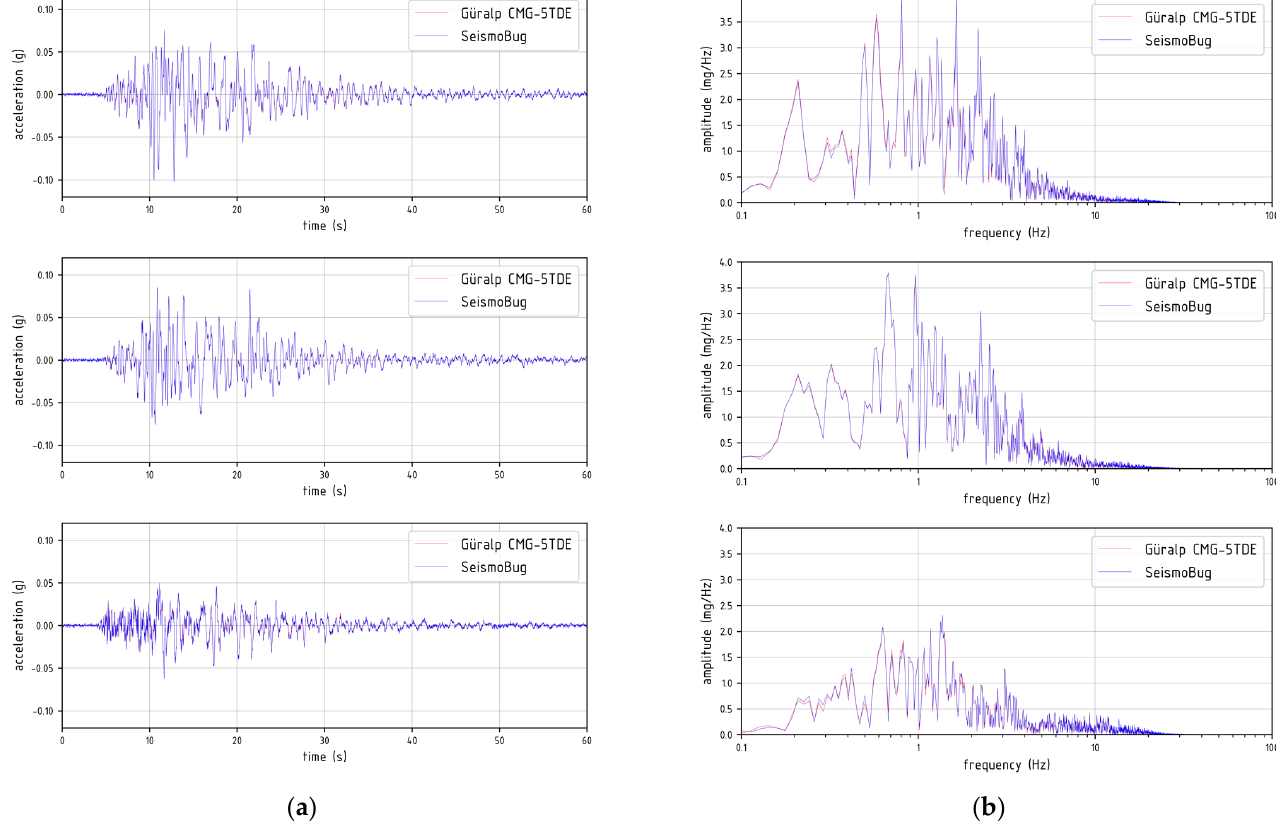
Figure 9. Comparison of acceleration records for the M6.5 Lefkada earthquake between SeismoBug © and Güralp © Systems accelerographs in ( a ) time and ( b ) frequency domains (components X, Y, Z from top to bottom).